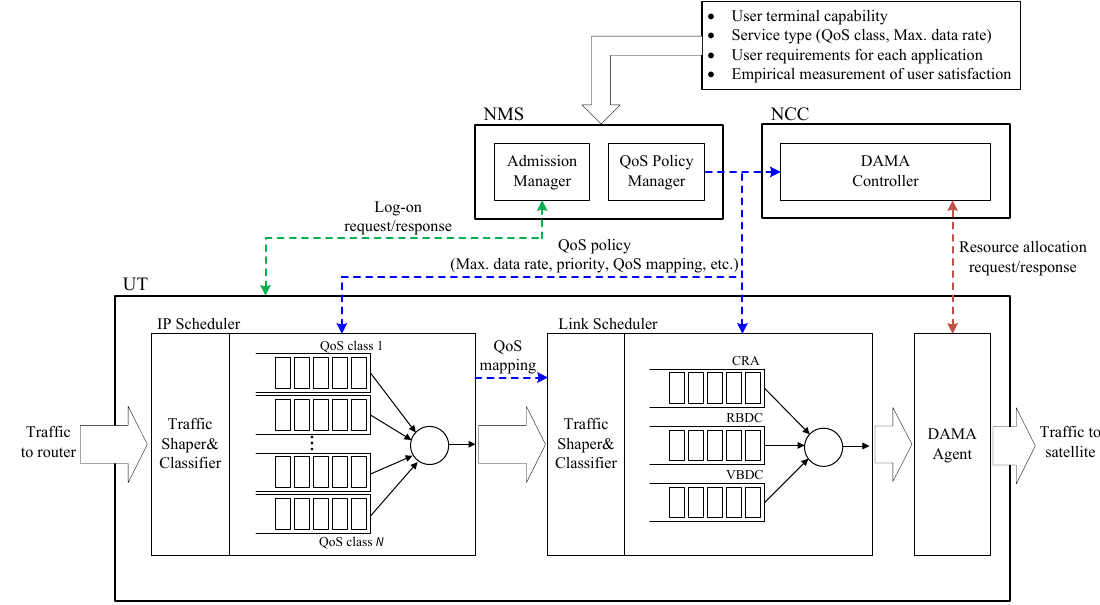
Figure 3. System model of the proposed design (QoS support). DAMA, demand assigned multiple access; UT, user